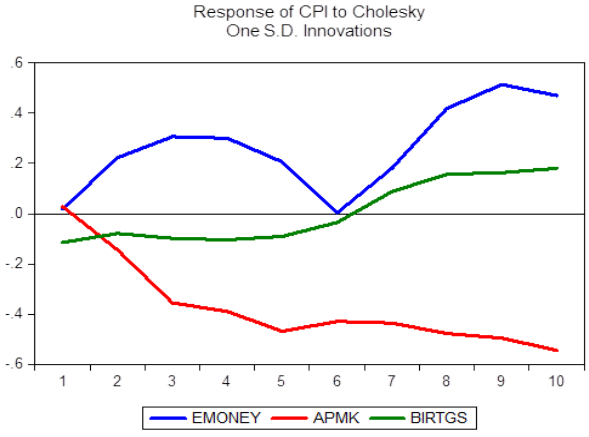
Figure 4: CPI Response to the Shock of Non-cash Transaction Variables